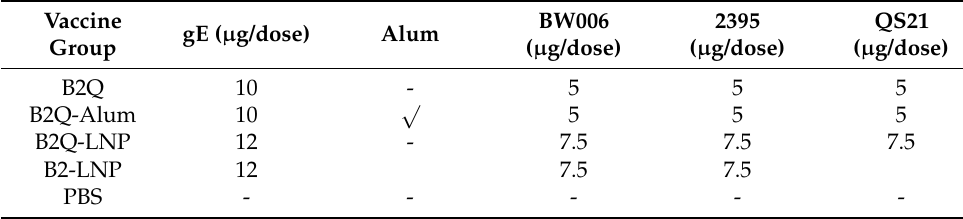
Table 2. Feeding components of each dose of vaccine for the encapsulation study. Vaccine